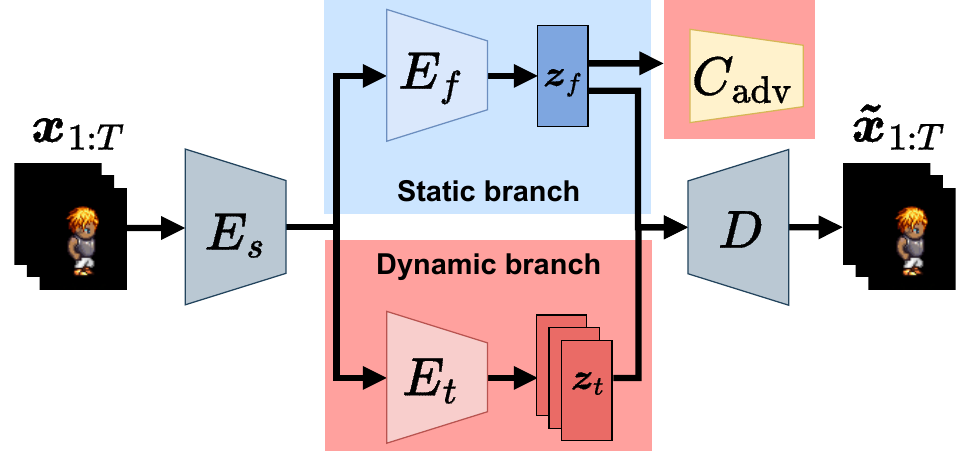
Figure 1. Overview of proposed model. The model consists of an auxiliary adversarial classifier C adv , a decoder D , a shared encoder E s , a static encoder E f , and a dynamic encoder E t . x 1: T and ˜ x 1: T denote input and reconstructed videos, respectively, and z f and z t indicate static and dynamic latent variables,